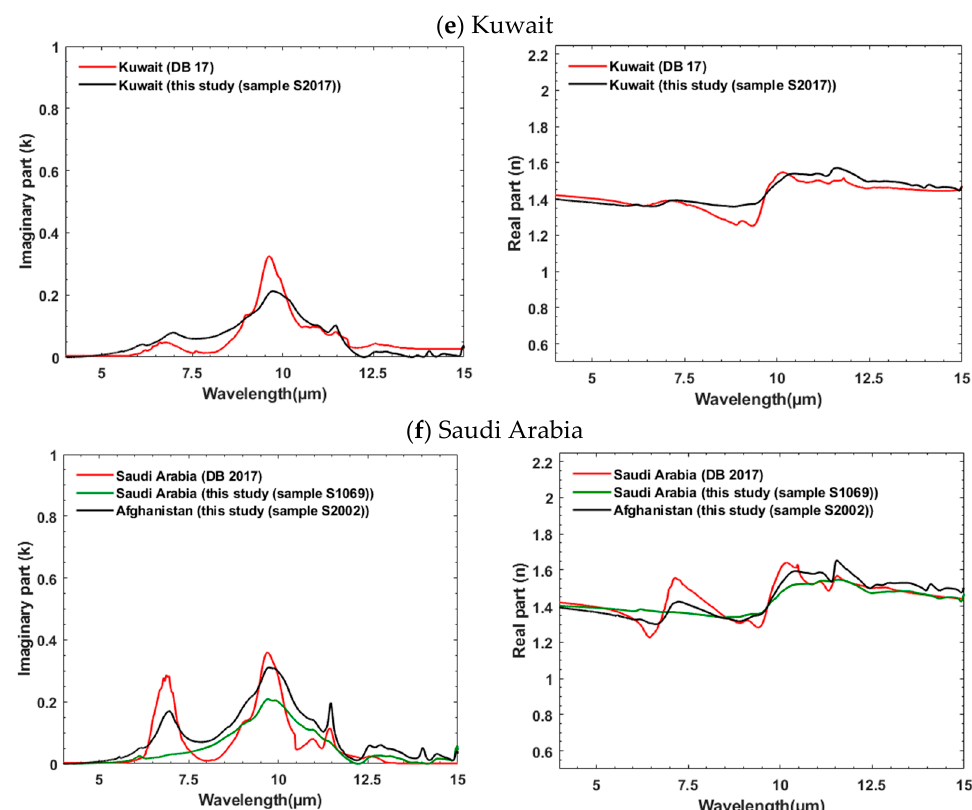
Figure 6. ( a – f ) comparison of k (left panel) and n (right panel) obtained from this study with the ones determined by Di Biagio et al. (2017) [20] for samples from similar geographic locations. Figure 6f compares samples from both Saudi Arabia and Afghanistan to illustrate comparable spectral diversity linked to their similar mineralogical content.